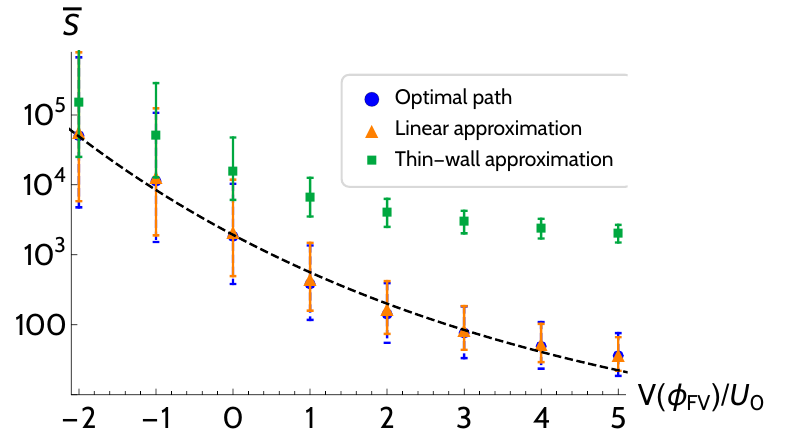
Figure 6. Evolution of the median of the action, with error bars representing data between the (cid:12)rst and third quartiles of each distribution, for the optimal path, the linear (straight-path) and the thin wall approximations, along with a (cid:12)tting curve (see